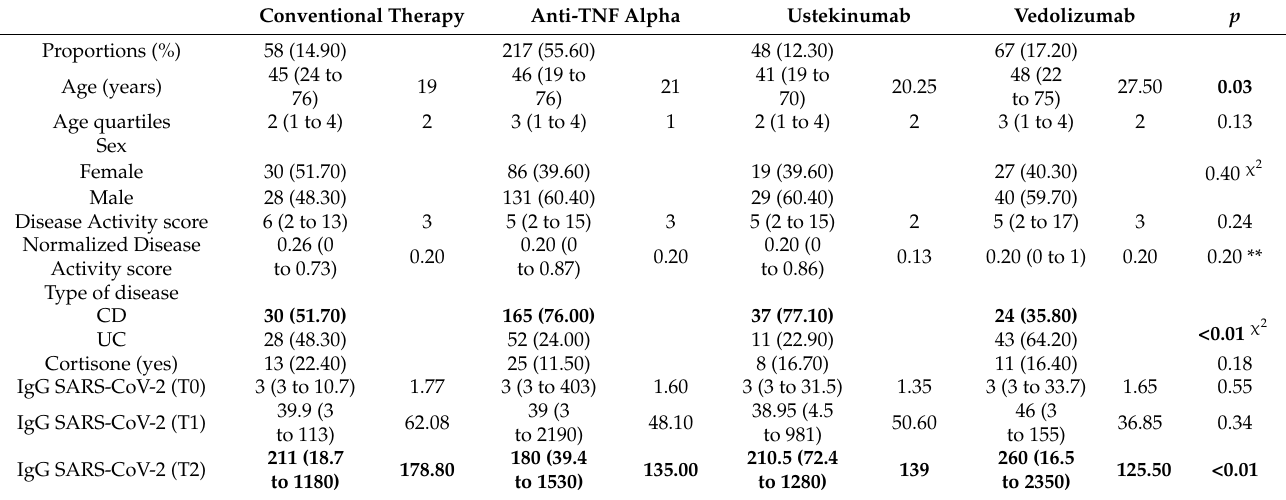
Table 3. Description of the whole sample according to type of treatment. N: 390. All data are shown as median (min to max) and IQR for continuous variables and as n (%) for